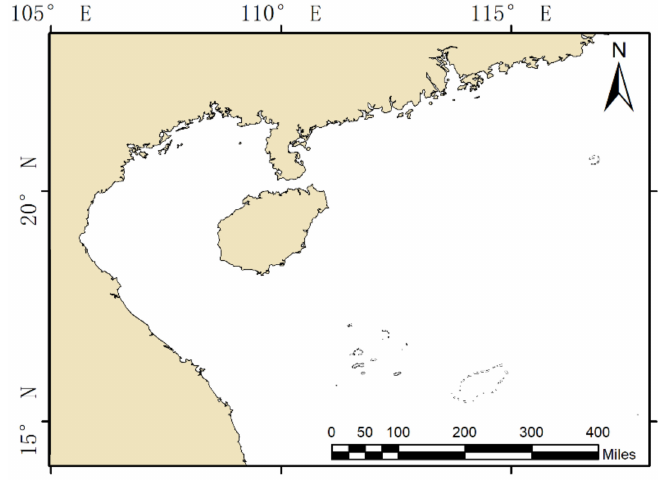
Figure 1. Map of the northern South China Sea (14 ◦ N–23.3 ◦ N, 105 ◦ E–118 ◦